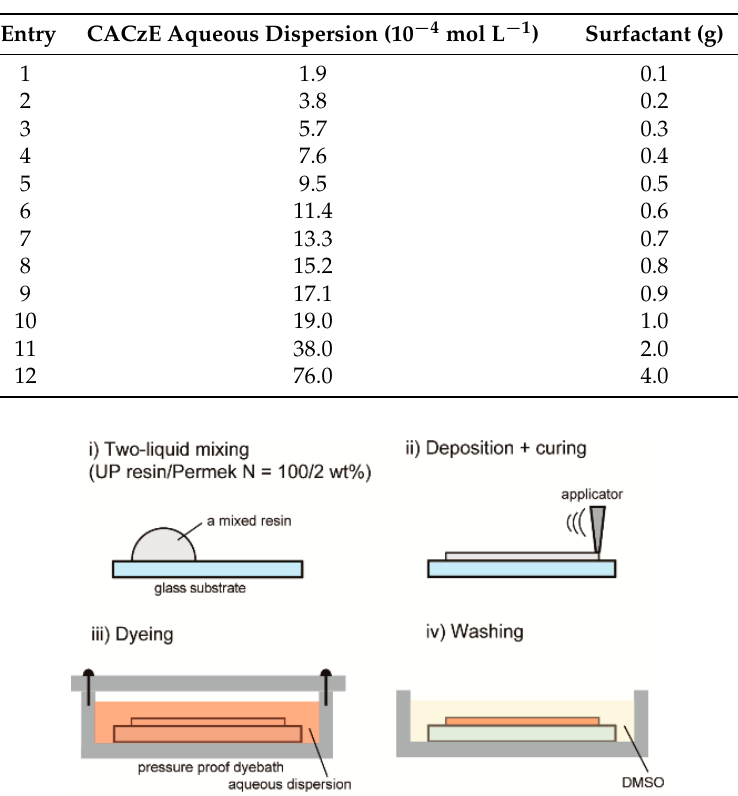
Table 1. Experimental conditions for the aqueous dispersions.